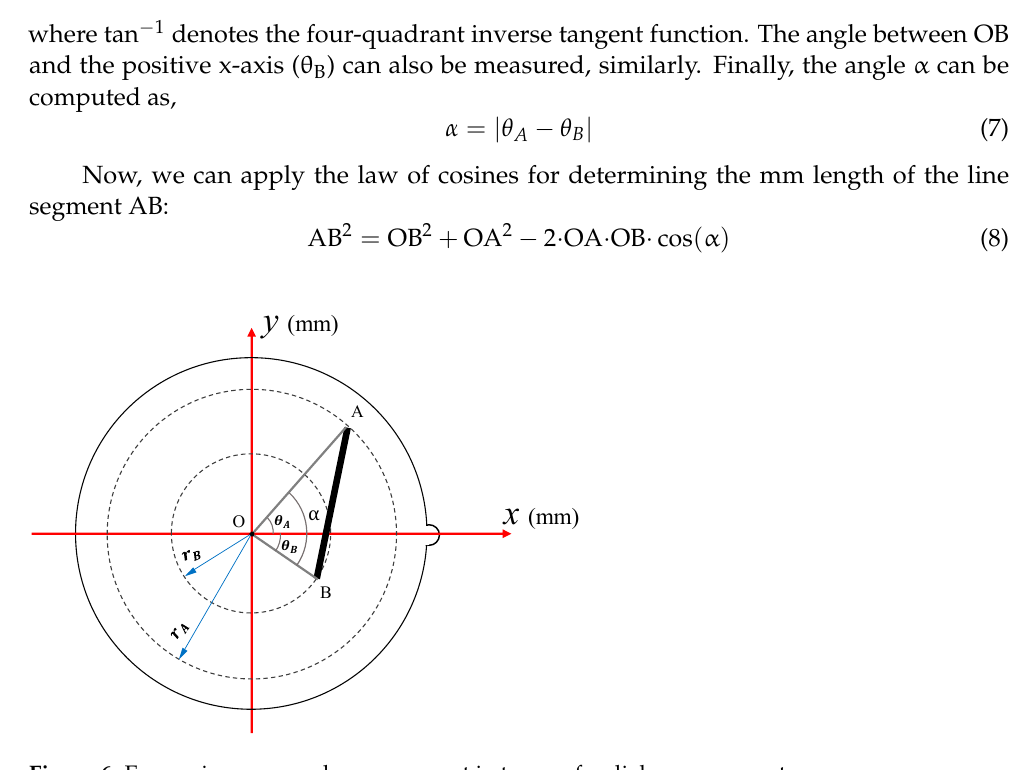
Figure 6. Expressing a general measurement in terms of radial measurements.